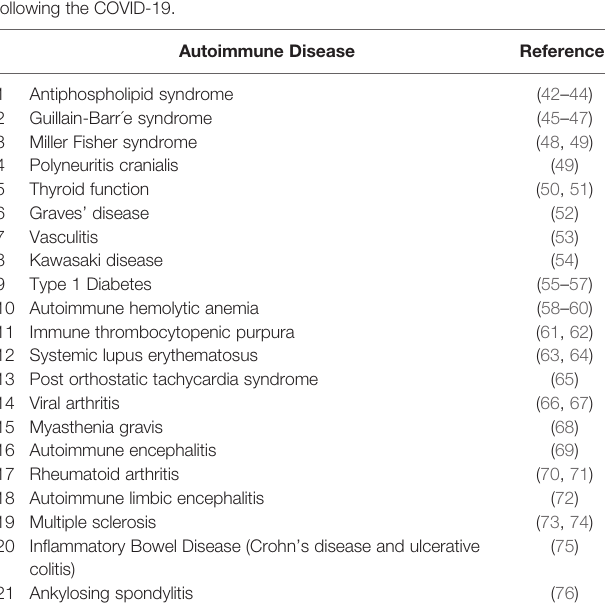
TABLE 4 | The literature review results for autoimmune conditions triggered following the COVID-19.